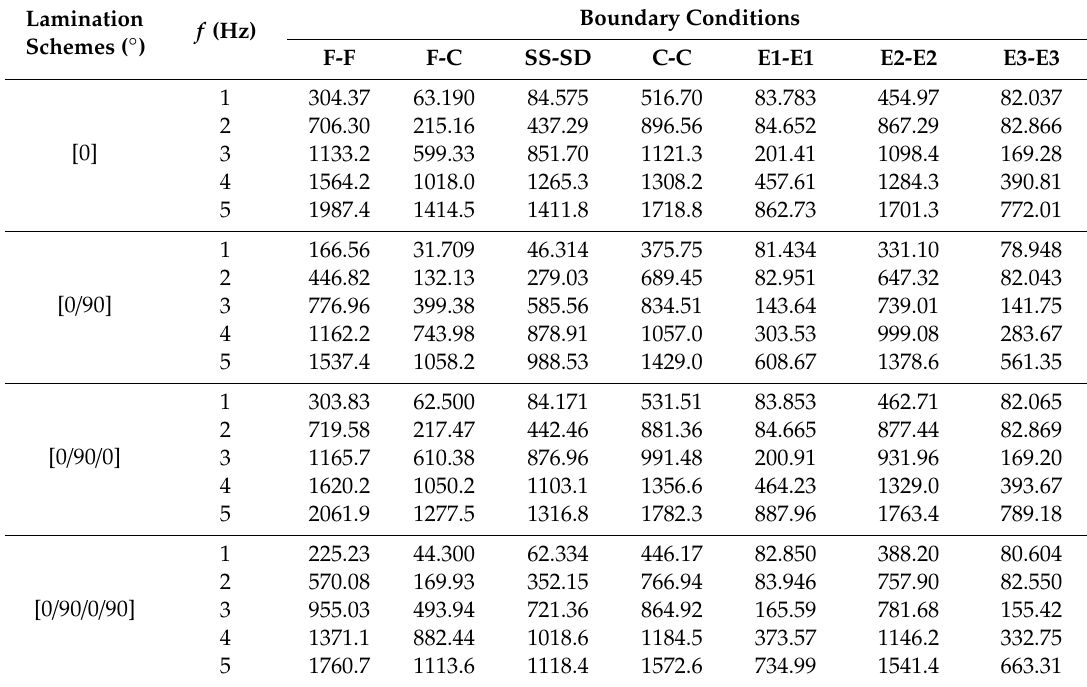
Table 7. Frequencies (first five modes) for a hyperbolical curved laminated composite beam with diverse lamination schemes and boundary